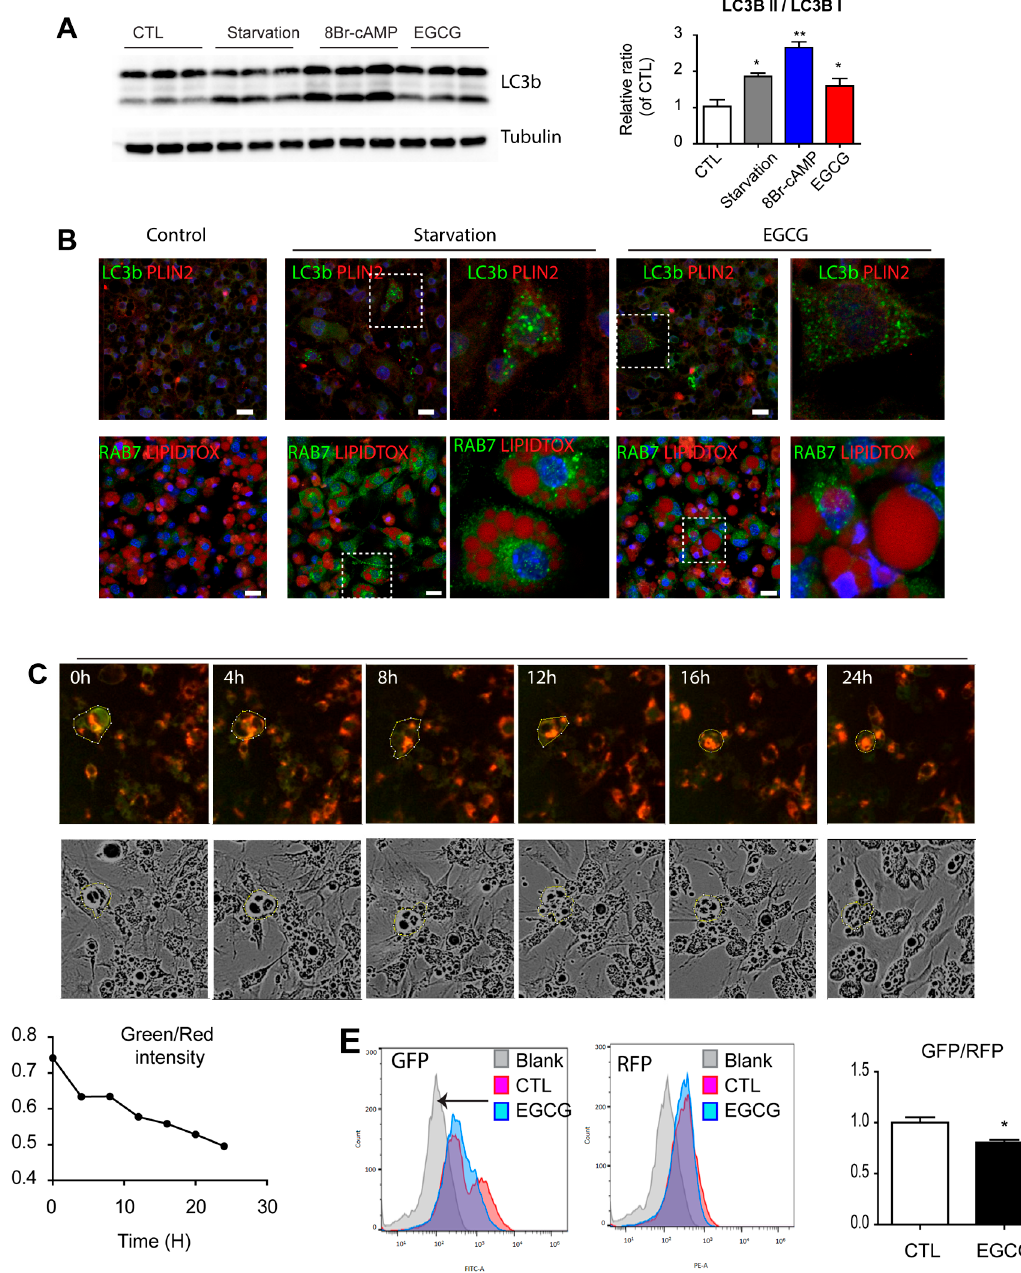
Figure 4. Effects of EGCG on autophagy responses in adipocytes. ( A ) Immunoblot analysis of LC3b expression in adipocytes differentiated from C 3 H 10 T1/2 treated with starvation medium, 8Br-cAMP (1 mM) and EGCG (10 µ M) for 1 day. p values were calculated using the two-tailed unpaired t -test ( n = 3, means ± SE; * p < 0.05, ** p < 0.01); ( B ) Immunofluorescence staining of LC3b/PLIN2 or RAB7/LipidTox in adipocytes differentiated from C 3 H 10 T1/2 treated with 8Br-cAMP (1 mM) and EGCG (10 µ M) for 24 h. Nuclei were counterstained with DAPI. Bars = 20 µ m; ( C ) Representative images from long-term live imaging of adipocytes expressing LC3B-GFP-RFP reporters treated with EGCG; ( D ) Time course analysis of GFP/RFP ratio from ( C ); ( E ) Flow cytometric analysis of adipocytes expressing LC3B-GPF-RFP reporters treated with